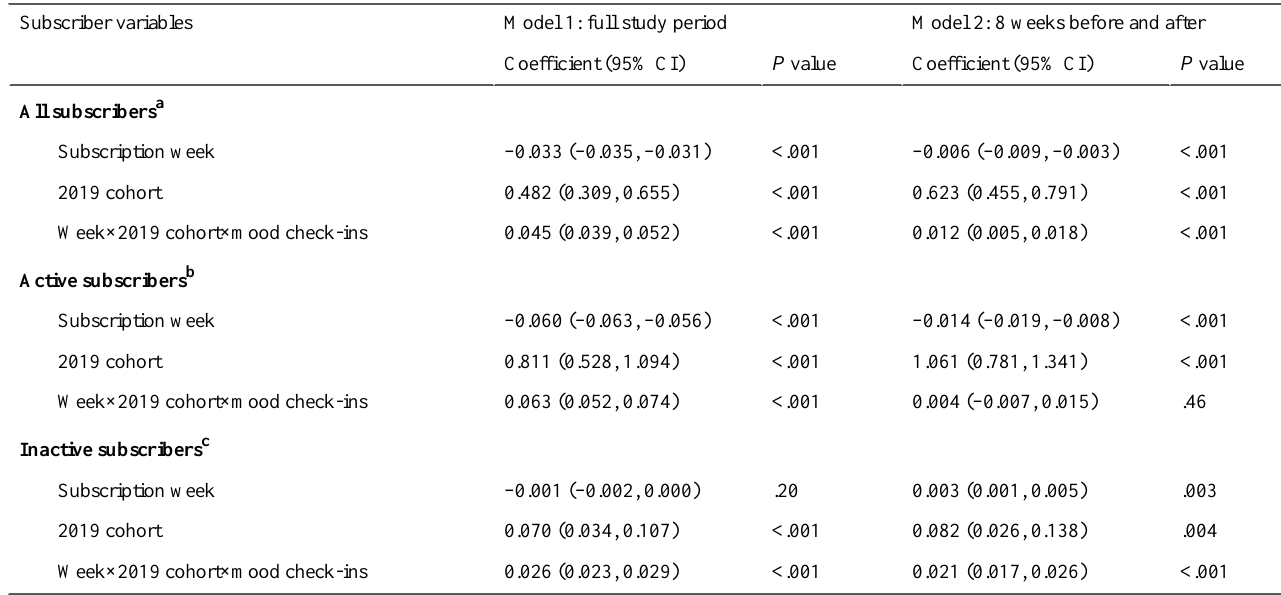
Table 2. Effect (ordinary least squares estimates) of the introduction of the mood check-in feature on average weekly meditation sessions.